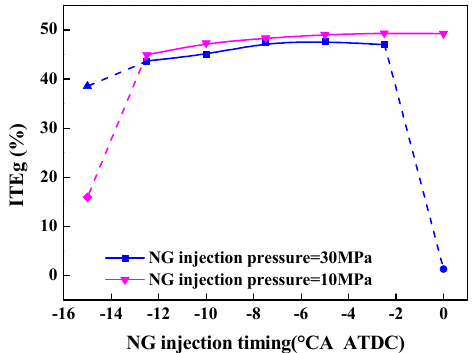
Figure 10. Impact of NG injection timing on ITEg.